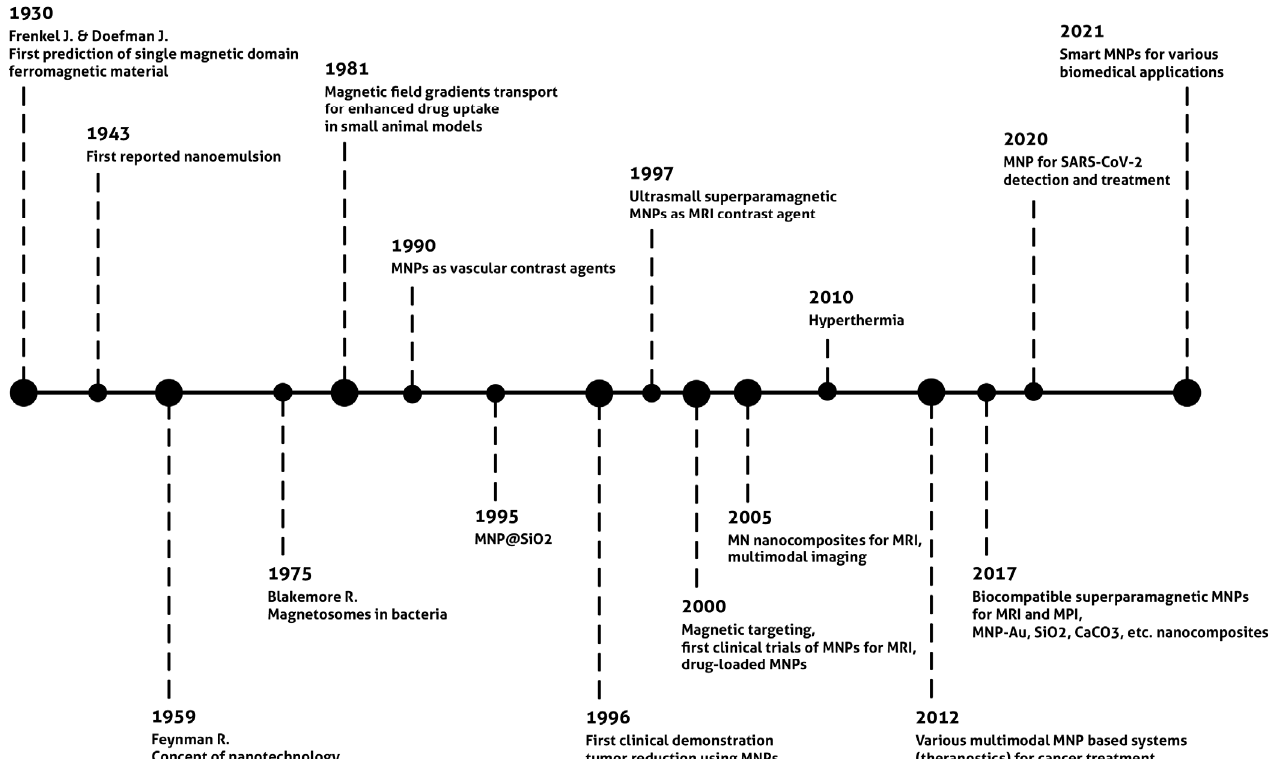
Figure 2. Historic timeline for development of MNPs.